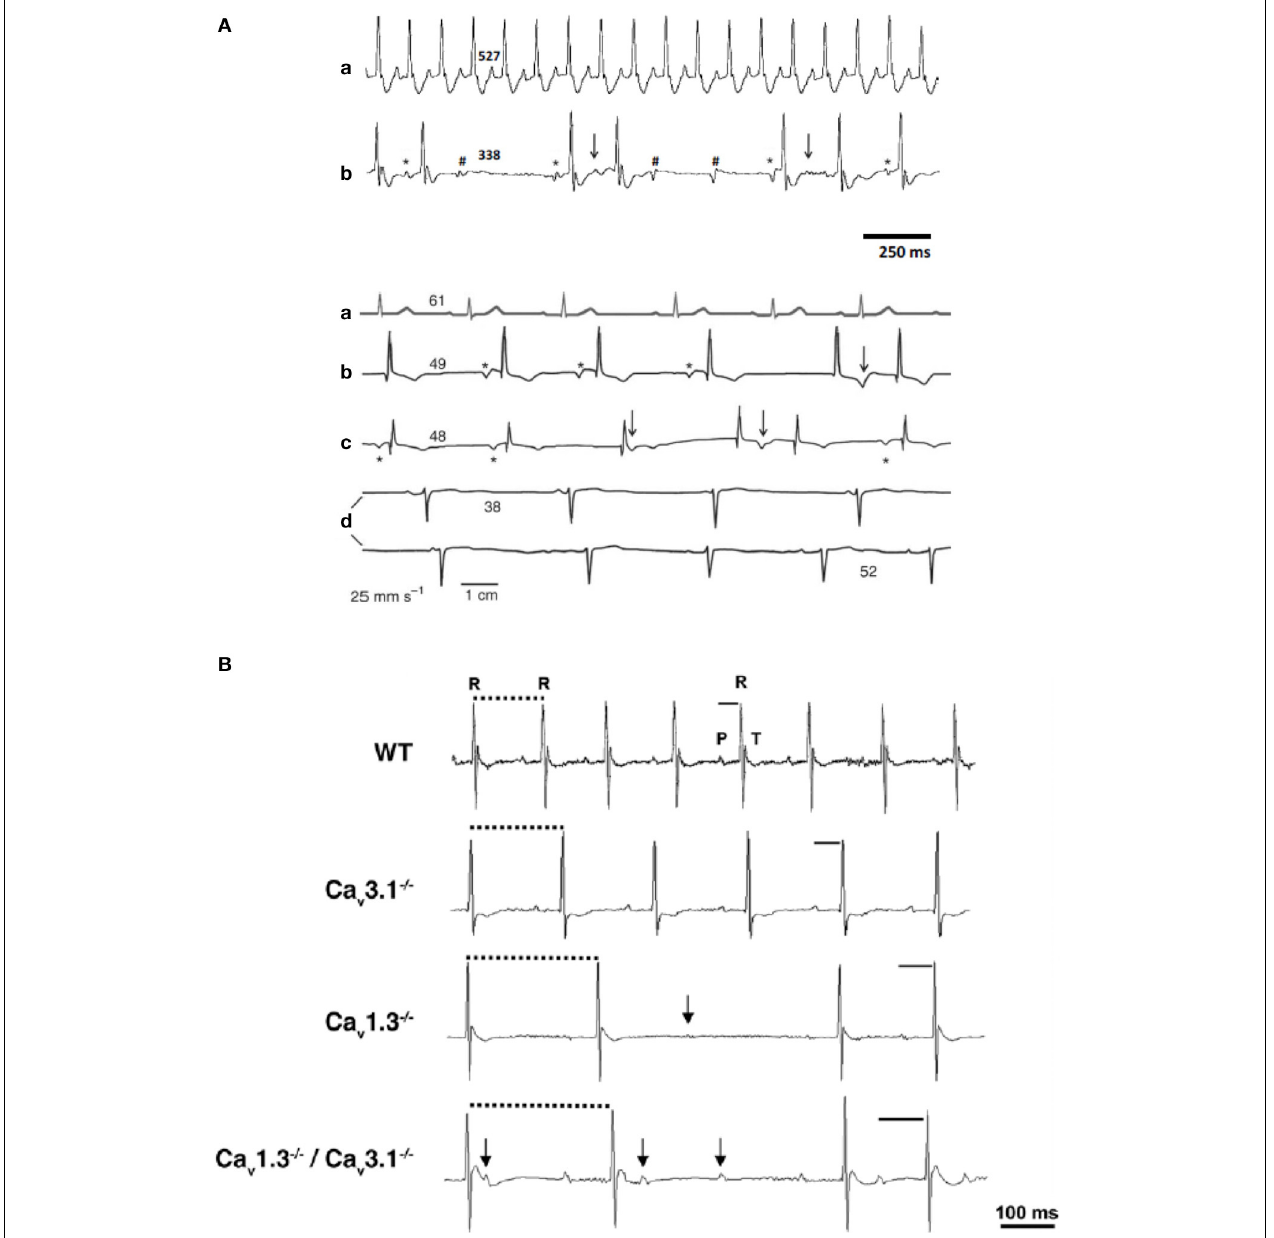
FIGURE 4 | Cardiac VGCCs in cardiac automaticity pathology. (A) ECG sample recordings from WT (a) and Ca v 1.3 − / − mice (b). (B) ECG recordings from a healthy person (a) and three individuals with SANDD syndrome (b–d). Asterisks mark P waves that precede QRS complexes; arrows indicate waveforms that suggest P waves coinciding with T waves; hashes indicate not conducted P waves. Numbers indicate heart rate (bpm) calculated from the corresponding beat-to-beat R-R interval